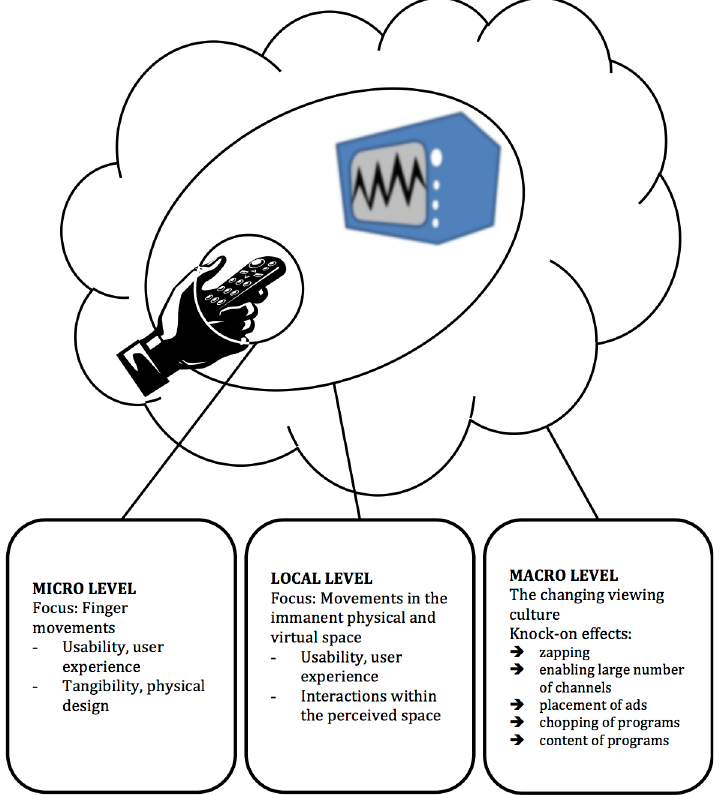
Figure 1. Illustration of the remote control device (RCD) case in terms of the levels of